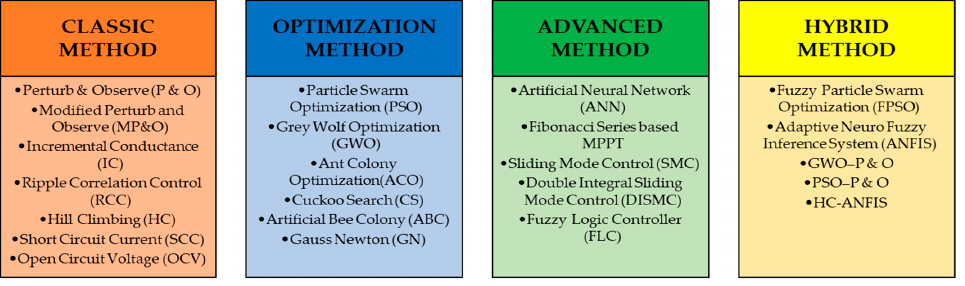
Figure 8. Basic classification of MPPT techniques.